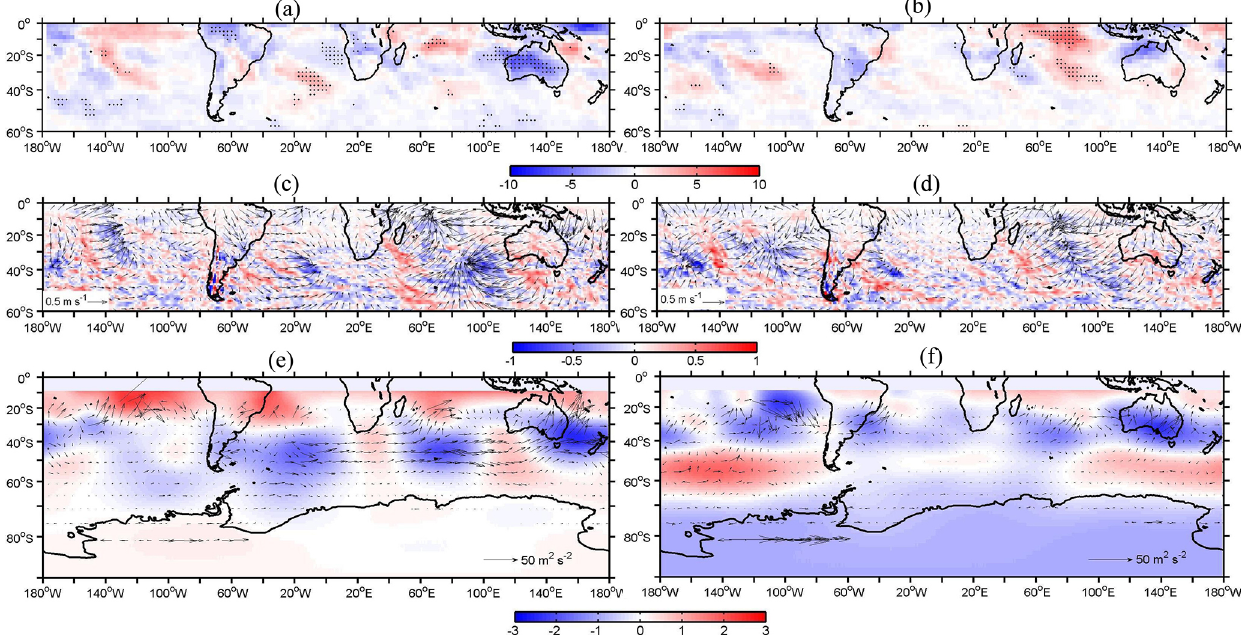
Figure 6. Climatological mean sea level pressure (MSLP, in hPa) and the 10m wind field (vector) over the periods of (a) 1979–1999 and (b) 2000–2020, and regression maps of MSLP (in Pa) and the 10m wind field (vector) on the summertime SAOD index over the periods of (c) 1979–1999 and (d) 2000–2020. Shaded regions and red vectors indicate that the confidence level is above 95%.